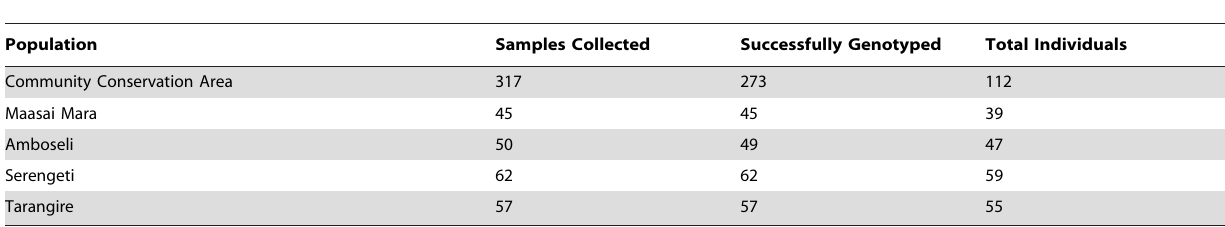
Table 2. Number of samples collected, successfully genotyped, and individuals for all five populations sampled in Kenya and Tanzania.